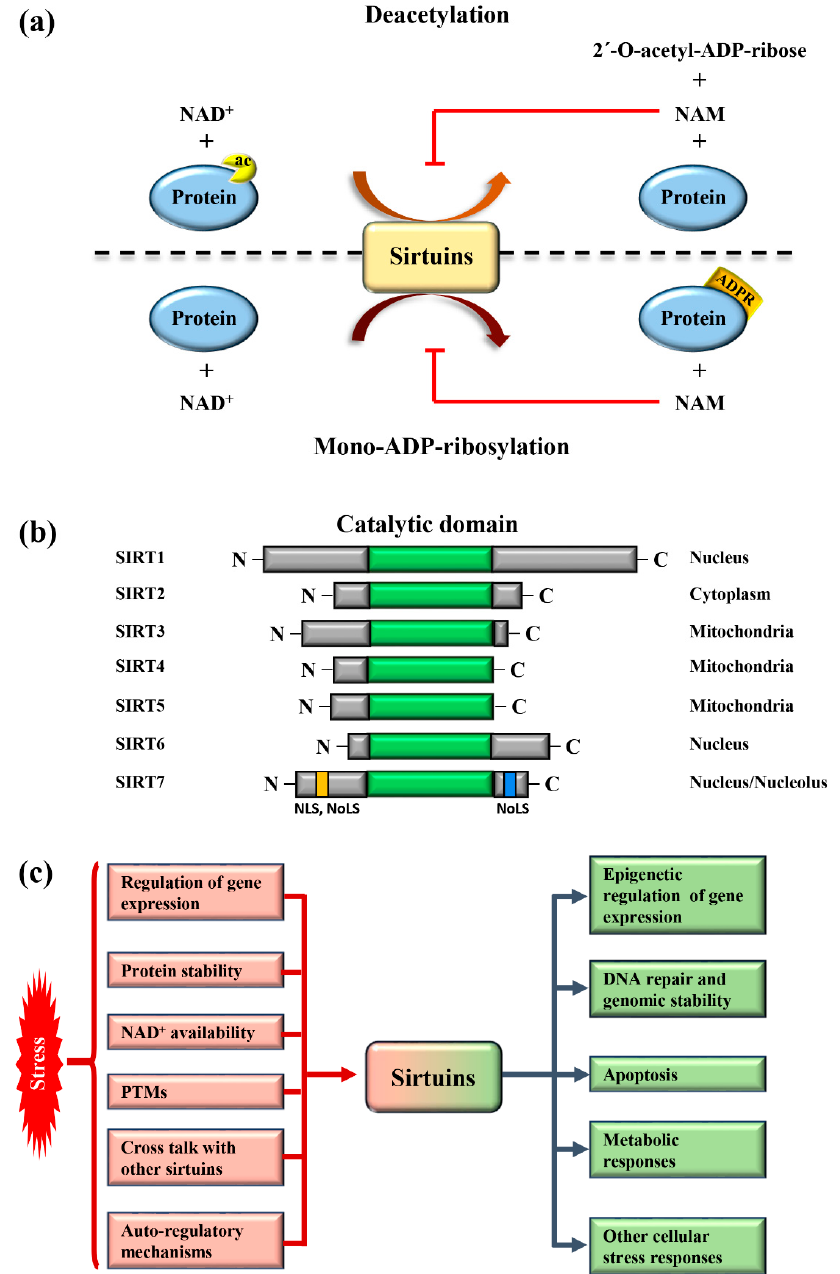
Figure 1. Mammalian sirtuins: general functions and activation in response to stress ( a ) Schematic representation of the main enzymatic activities of mammalian sirtuins. Sirtuins catalyze deacetylation of protein targets by transferring the acetyl group to NAD+, concomitant with the release of nicotinamide (NAM) and 2 (cid:48) -O-acetyl-ADP-ribose (upper panel). In the mono-ADP-ribosylation reaction, the ADP-ribose (ADPR) is transferred from NAD + to the substrate, leading to release of NAM (lower panel). NAM is a potent inhibitor of the enzymatic activity of sirtuins. ( b ) Schematic representation of the structure and subcellular distribution of mammalian sirtuins. SIRT7 nuclear and nucleolar localization sequences (NLS and NoLS, respectively) are indicated. ( c ) Scheme depicting the mechanisms involved in sirtuins activation following stress (red) and their main biological functions